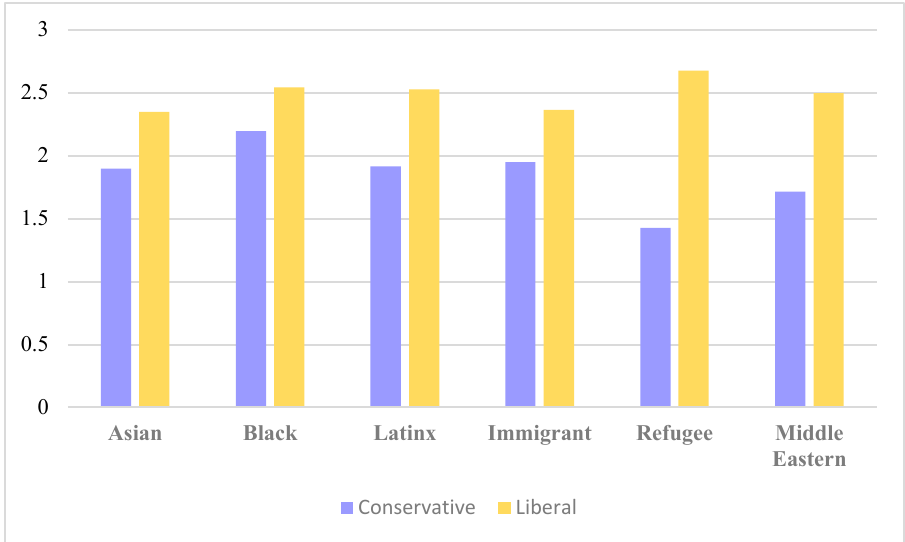
Figure 1. Mean hate score of Facebook posts referencing racial and ethnic groups by conservative and liberal news media. Higher values indicate more supportive benevolent speech, while lower values mean greater hate speech.